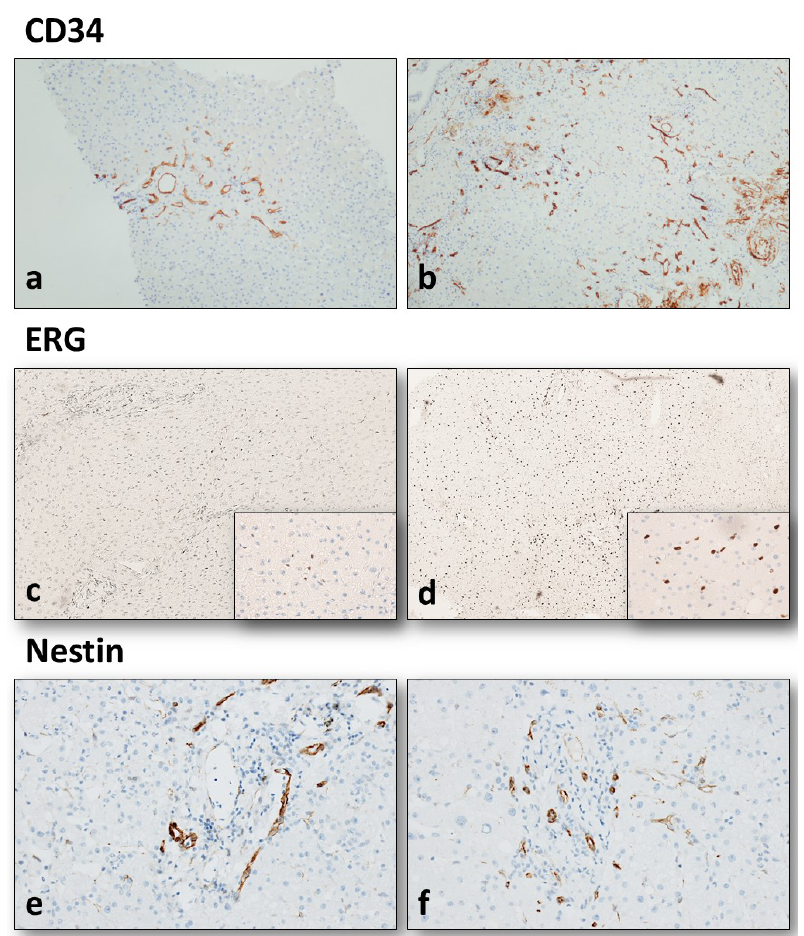
Figure 1. Immunohistochemistry results. CD34 immunoreactivity increased in liver sinusoids from allocation biopsy (( a ), 2× magnification) to post-perfusion biopsy (( b ), 2× magnification), as a progressively increasing periportal endothelization ( p < 0.001). The increased expression of ERG was also statistically significant ( p < 0.001) between allocation biopsy (( c ), 2× magnification) and post-perfusion biopsy (( d ), 2× magnification). The higher density of ERG-positive nuclei is highlighted by higher magnification (small squares, 20× magnification). Two portal tracts immunostained by Nestin (( e , f ), 10 × magnification), showing a variable number of periportal capillaries and a mild immunoreactivity in adjacent